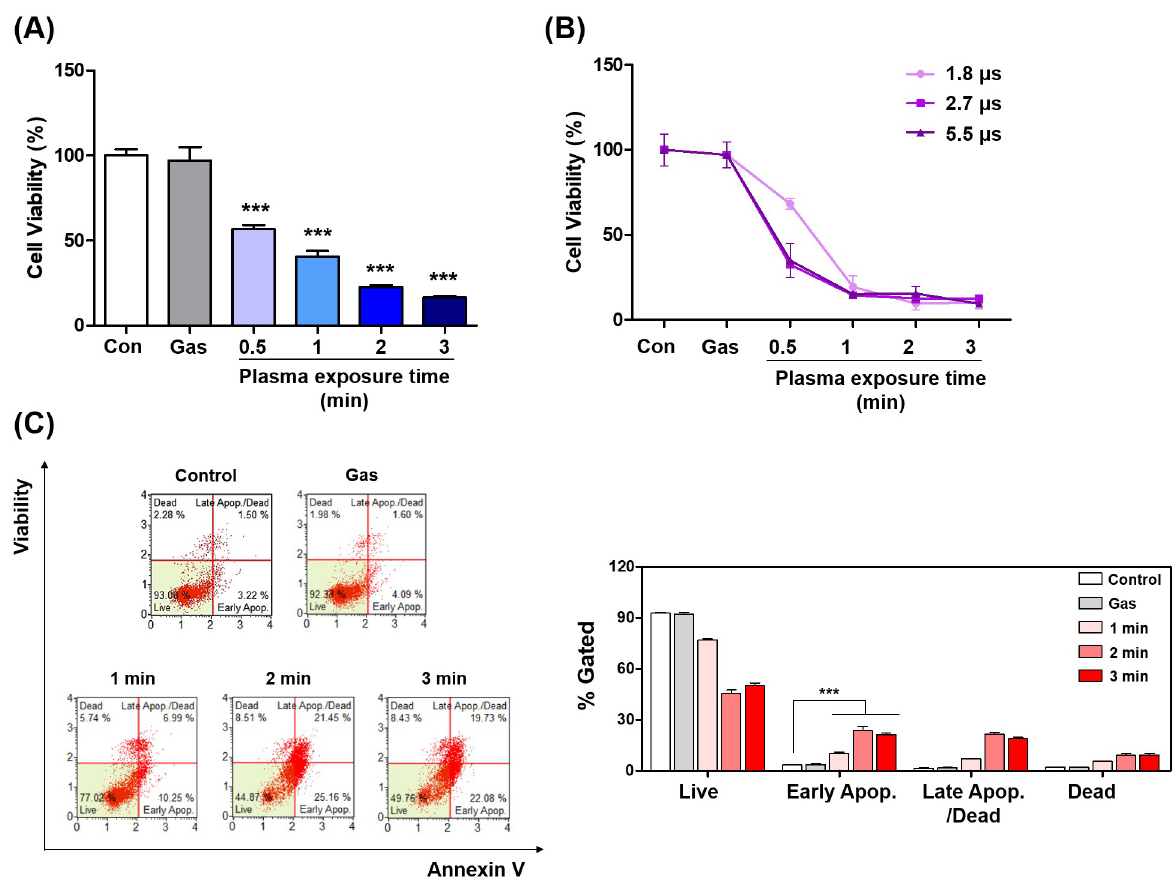
Fig 7. Plasma activated medium (PAM) induces apoptosis in human cervical cancer cells. Cell viability measurement in HeLa cell lines at 24 h after PAM treatment. (A) Plasma conditions; the gas flow rate 5 SLM. Medium was exposed by plasma operated with the applied voltages at the pulse width of 2.7 μ s for 0.5, 1, 2, and 3 minute. (B) Plasma conditions; the gas flow rate 5 SLM, applied voltage 7.5 kV pp , plasma exposure time 0.5, 1, 2, and 3 minute. (C) PAM induces apoptosis in HeLa cells. The percentage of the apoptotic cells was measured using the MUSE Cell Analyzer. Medium irradiated with plasma operated with the applied voltages at the pulse width of 2.7 μ s was applied to HeLa cells for 24 hours. Bar graph indicated the quantitative analyses of each population. Data represent the mean ± S.D. of n = 3 samples; ��� P < 0.001.